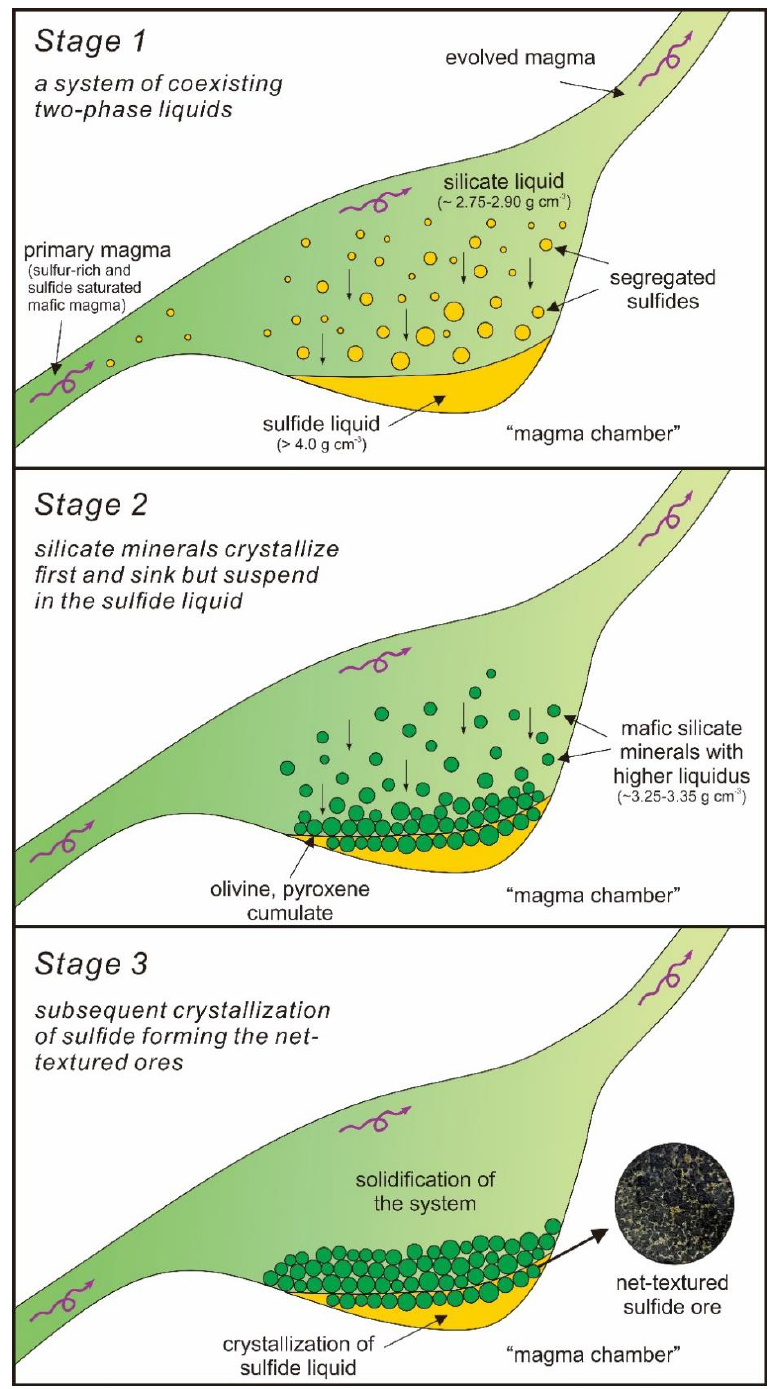
Figure 6. Schematic diagram illustrating the most likely magmatic processes that develop the net-textured ores. Stage 1: a sulfur-rich and sulfide saturated mafic magma led to sulfide melt exsolution/segregation in a “magma chamber”, in which dense (>4.00 g cm −3 ) [51] sulfide liquid droplets sink at the base overlain by the less dense (~2.75–2.90 g cm −3 ) silicate liquid [52]. Stage 2: mafic silicate minerals (olivine, orthopyroxene, and clinopyroxene) have high liquidus temperature than sulfides and higher density (~3.25−3.35 g cm −3 ) than silicate liquid, thus begin to crystallize first and tend to sink at the base of the silicate liquid, but would suspend in the denser sulfide liquid [52]. Stage 3: Subsequent crystallization of sulfide liquid and solidification of the system results in the observed net-textured Ni-Cu ores. It is thus logical to assume that the net-textured sulfide minerals are in equilibrium with the coexisting silicate minerals dominated by olivine.